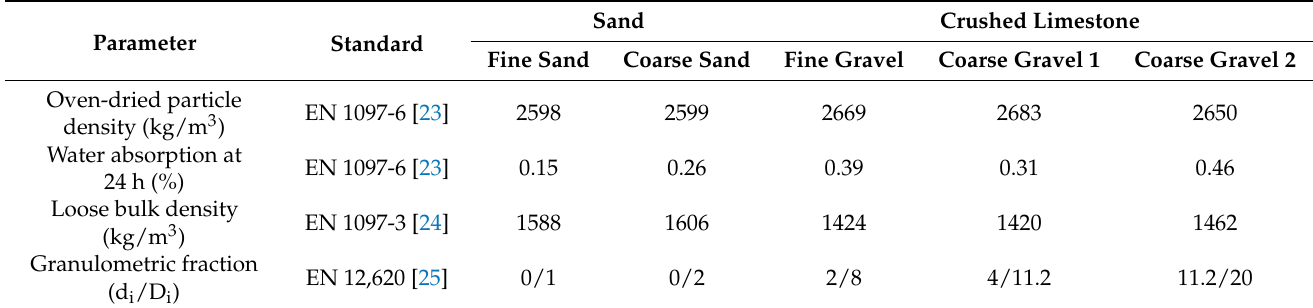
Table 1. Properties of the natural aggregates.